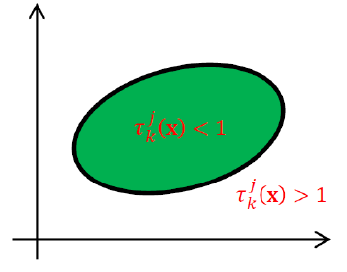
Figure 2. Example of a hyper-ellipsoid generated by the two parameters (𝛍 𝑘 and ∑ ) −1 of the dendrite. Taken from (Arce 𝑘 2017).